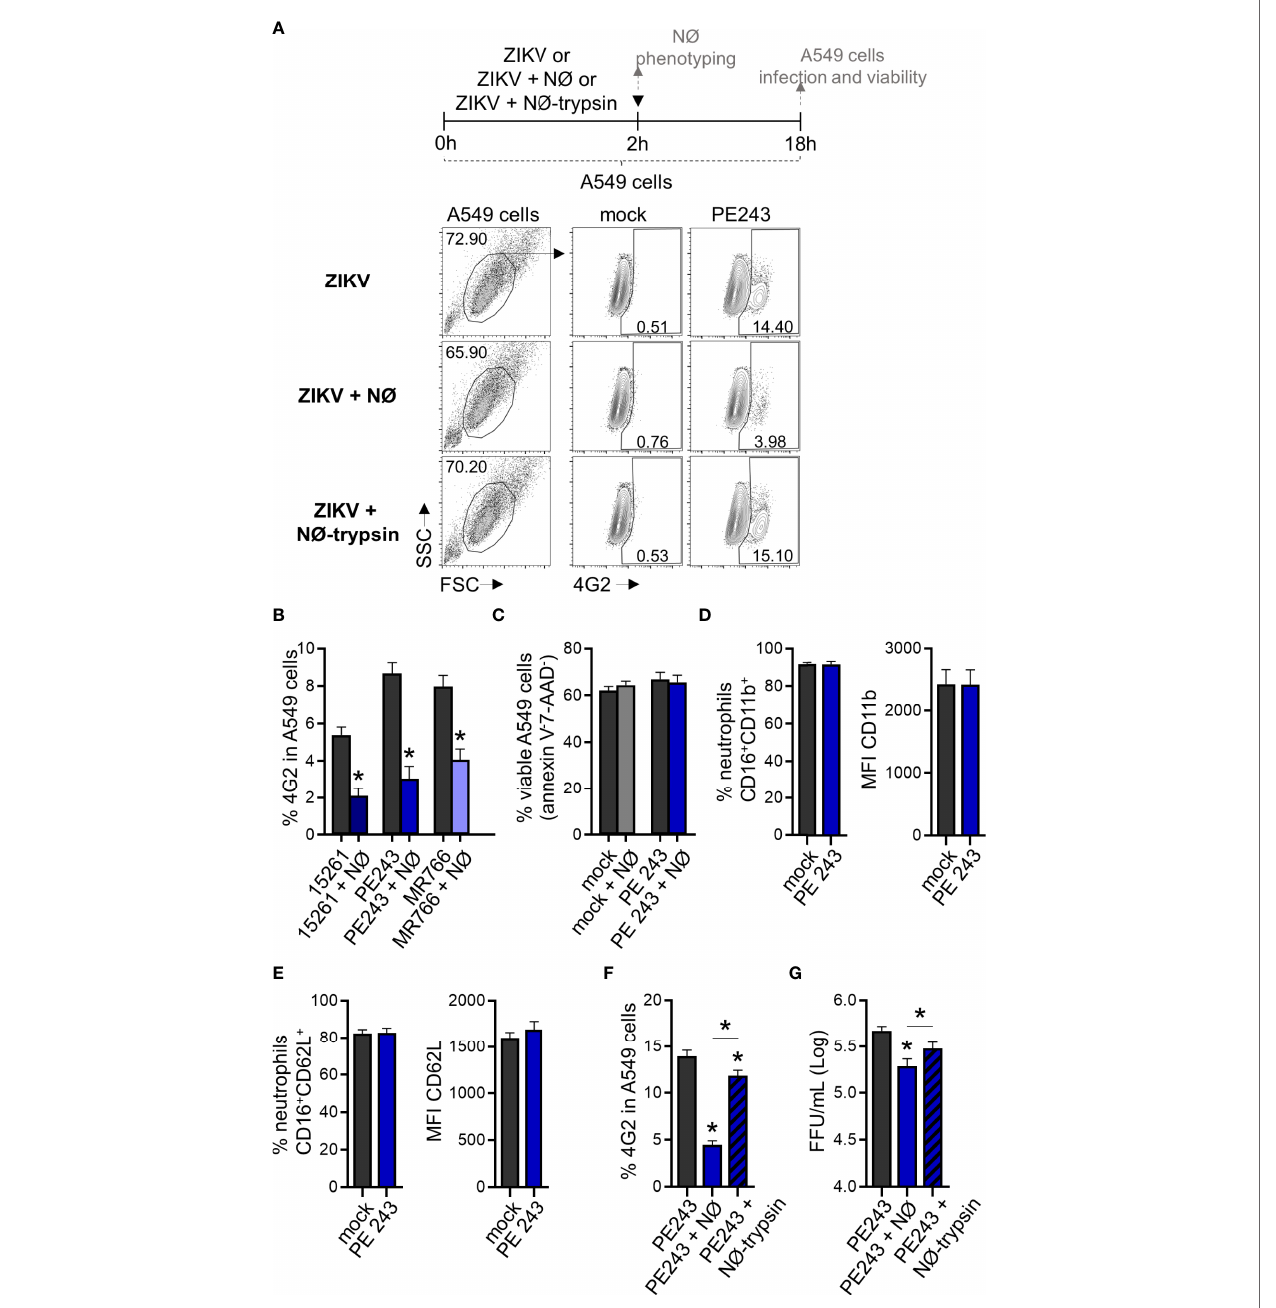
FIGURE 6 | Human neutrophils reduce ZIKV infection in A549 cells through contact. (A) Flow cytometry plots depicting the frequency of 4G2 + A549 cells at 18 hours post-infection with ZIKV PE243 (1 MOI). Cells were infected for 2 hours in the absence of neutrophils (ZIKV), presence of neutrophils (ZIKV + NØ), or presence of neutrophils pretreated with trypsin (ZIKV + NØ-trypsin). ZIKV PE243 is shown as a representative of the ZIKV strains ’ effects. Mock condition was used as a negative fl uorescence control. (B) Frequency of 4G2 + A549 cells at 18 hours post-infection with ZIKV strains (1 MOI) in the absence or presence of neutrophils. (C) Frequency of viable A549 cells (annexin V - 7-AAD - ) after 18 hours of infection with ZIKV PE243 (1 MOI) in the absence or presence of neutrophils during the infection. (D) Frequency of neutrophils CD16 + CD11b + and the mean fl uorescence intensity (MFI) of CD11b in that population after 2 hours of interaction with A459 cells stimulated with mock or PE243. (E) Same analysis as in (D) was applied to the CD62L molecule. (F) Frequency of 4G2 + A549 cells at 18 hours post-infection with ZIKV PE243 in the presence of trypsin pretreated neutrophils. (G) ZIKV PE243 loads on A549 cell culture supernatant at 18 hours post-infection in the presence of trypsin pretreated neutrophils. Bars indicate SEM. Three-four independent experiments are shown (n = 7 – 15). The asterisk (*) denotes the statistical difference between the absence and presence of neutrophils (B, F, G) or neutrophils pretreated with trypsin (F), and neutrophils pre-treated or not with trypsin. ( ▼ ) indicates the moment A549 cells were washed to remove the stimuli. NØ,